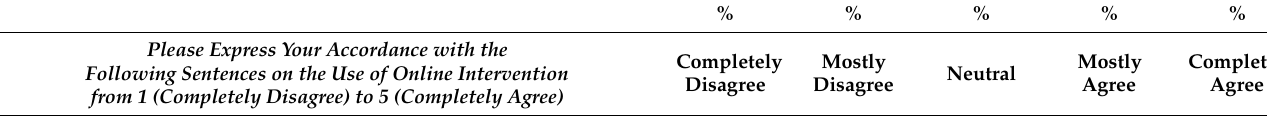
Table 6. Level of accordance with sentences on the use of online